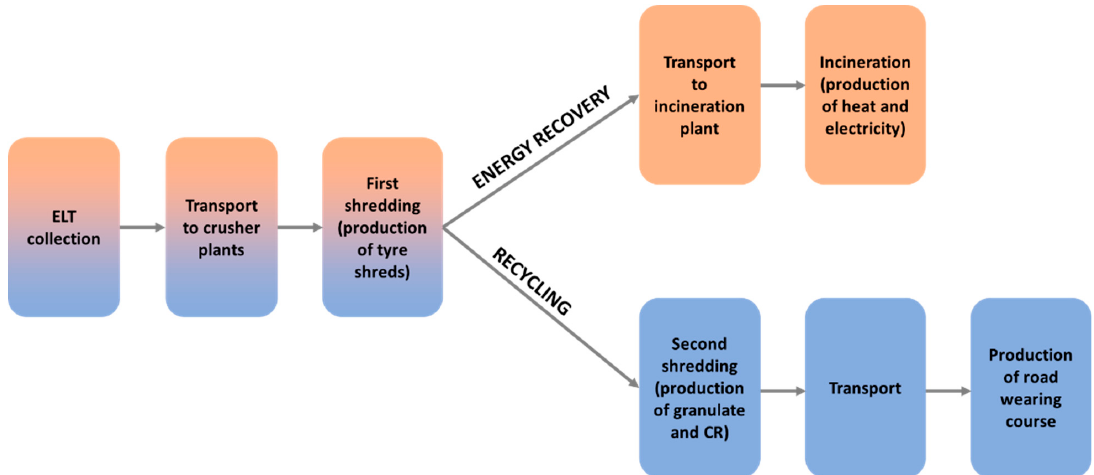
Figure 1. Flow chart of the two analysed scenarios for the ELTs.